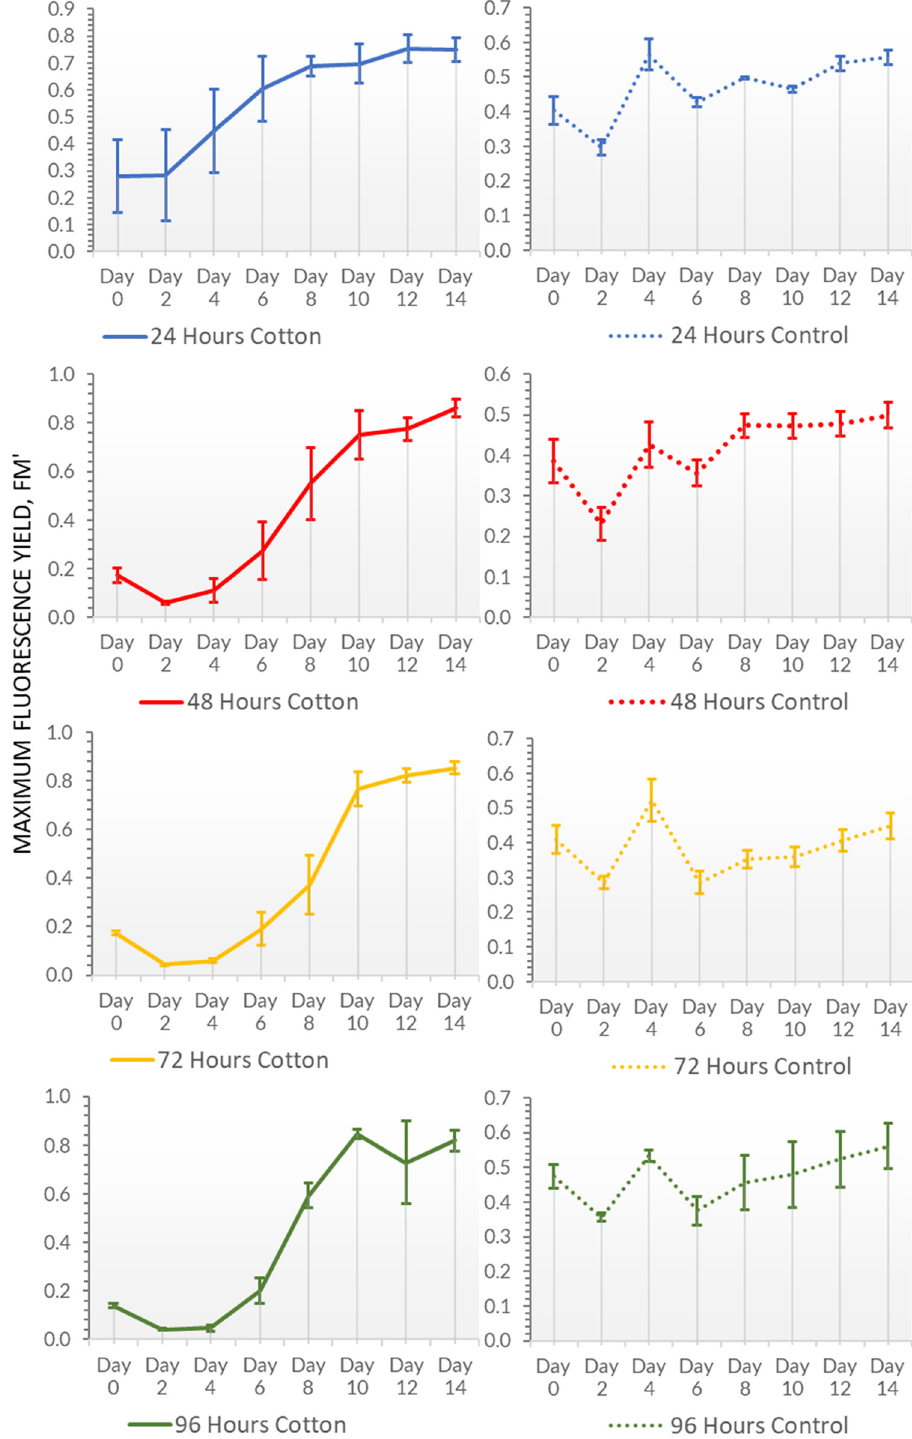
Figure 7: Open incubation of 50% w/w binder cotton samples following drying times of 24 h ( mean StDev = 0.098 ) , 48 h ( mean StDev = 0.067 ) , 72 h ( mean StDev = 0.042 ) , and 96 h ( mean StDev = 0.045 )